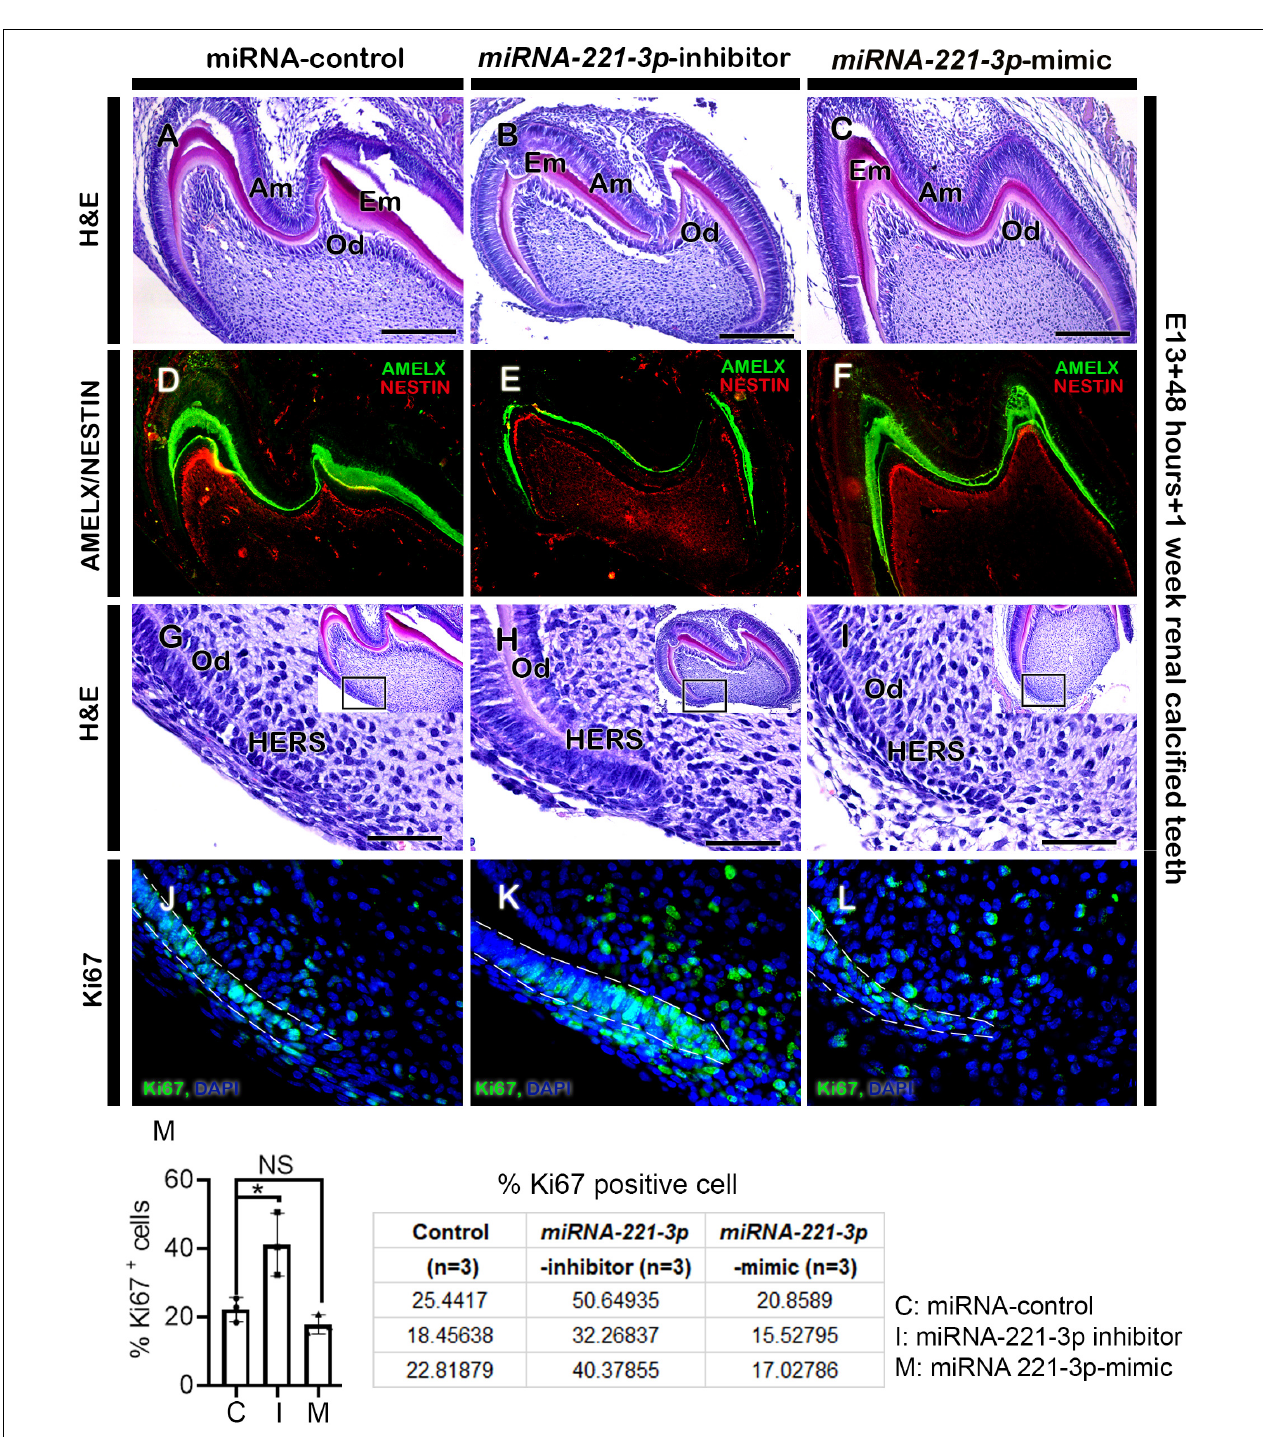
FIGURE 4 | Altered histogenesis and cellular events in 1-week renal calcified teeth. H&E staining showing 1 week renal calcified teeth after loss and gain of function of miRNA-221-3p ( A–C , n = 3). The inhibitor-treated tooth (B) is comparatively smaller with reduced extracellular matrix secretion compared to control and mimic (A,C) . The localizations of AMELX and NESTIN are weaker in inhibitor-treated specimen compared to mimic and control ( D–F , n = 3). H&E staining showing HERS in 1-week calcified teeth (G–I) . The cellular proliferation (green) along the HERS is higher in the inhibitor-treated specimen compared to mimic and control ( J–M , n = 3). DAPI (blue) stains the nuclei. Boxes in G–I are magnified views. Dotted lines (J–L) indicate the HERS. H&E, hematoxylin and eosin; Am, ameloblasts; Od, odontoblasts; AMELX, amelogenin; HERS, hertwig’s epithelial root sheath. Data were evaluated for statistical significance using unpaired, two-tailed t -test. ∗ Indicates p < 0.05; NS, not significant. Scale bars: 200 µ m (A–F) , 50 µ m (G–L) .